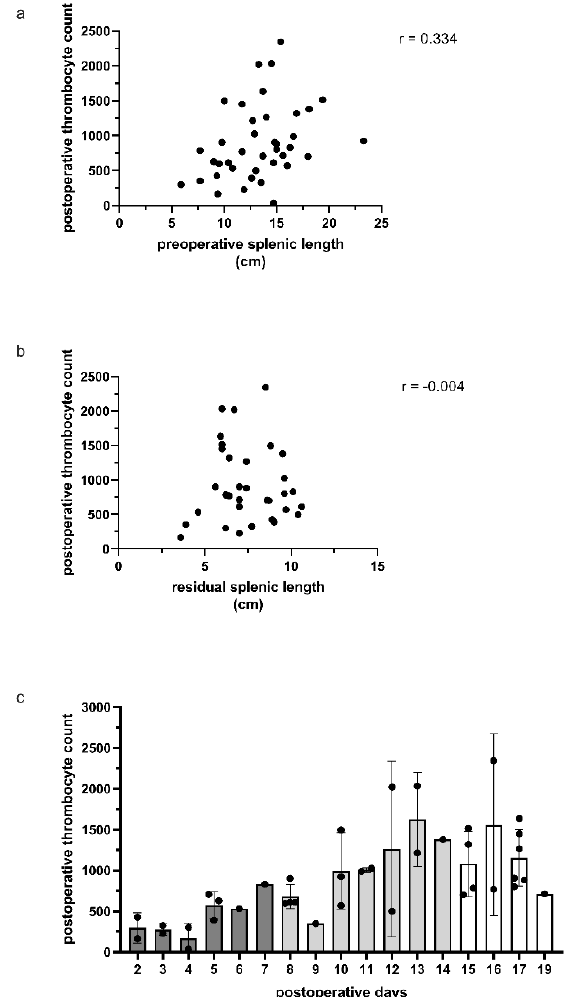
Figure 3. ( a ) The preoperative spleen size was related to the postoperative thrombocyte count, demonstrating a trend of higher thrombocytes postoperatively. ( b ) There was no association between residual spleen size and postoperative thrombocyte count. ( c ) The postoperative thrombocyte